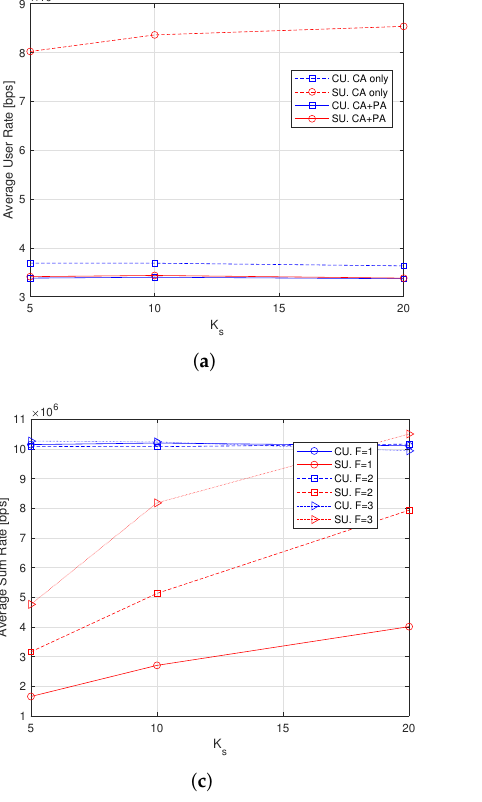
Figure 9. Average user rate, rate dispersion index and average sum-rate with Perfect CSI with K c = 30 users, 100 iterations. ( a ) Varying K s , F = 1; ( b ) Varying K s , F = 1; ( c ) Varying K s and F